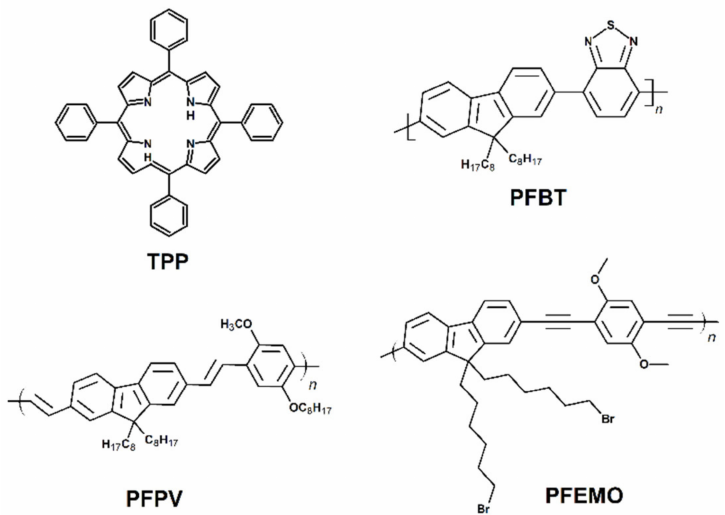
Figure 3. Chemical structure of TPP and fluorene-based polymers (poly[(9,9-dioctylfluorenyl- 2,7-diyl)-alt-co-(1,4-benzo-{2,1 (cid:48) ,3}-thiadiazole)] (PFBT) and poly[9,9-dibromohexylfluorene-2,7- ylenethylene-alt-1,4-(2,5-dimethoxy) phenylene] (PFEMO) (PFEMO), investigated in [53,62,63], re- spectively) used to obtained conjugated polymers nanoparticles for photodynamic